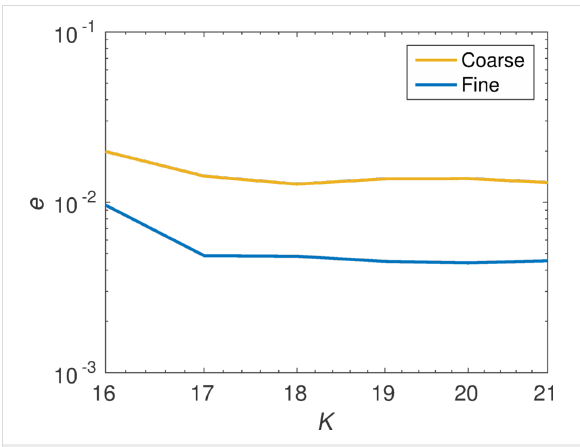
Figure 2: Convergence of the T-matrix calculation with the increase of the number of plane wave illuminations. The minimum number of illu- minations to solve for all the unknown entries of the T-matrix for the multipole order N = 2 is 16. The error is shown for two different calcula- tions, where the fine one has two times finer